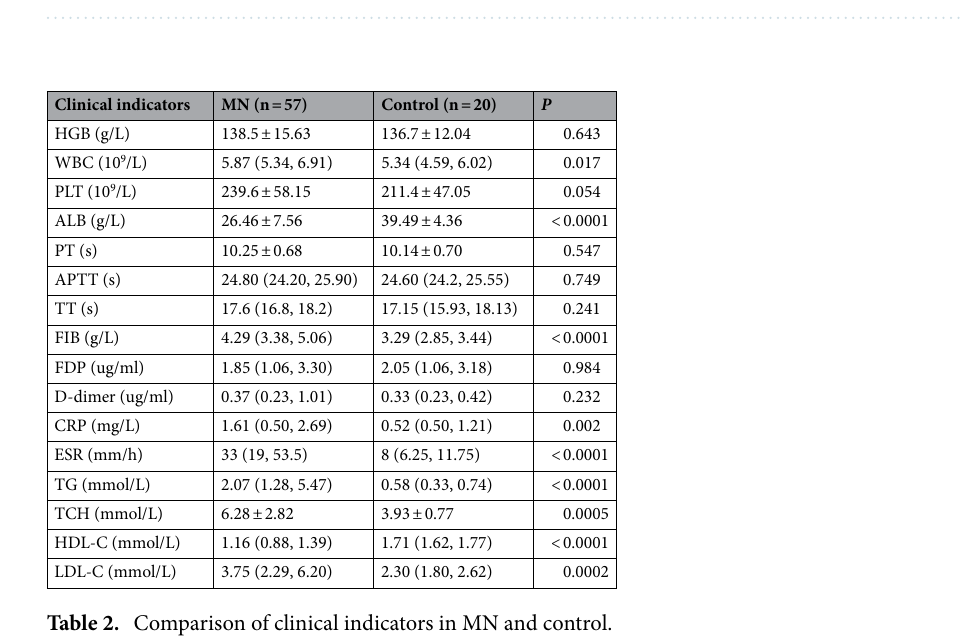
Table 1. General data for patients with MN.